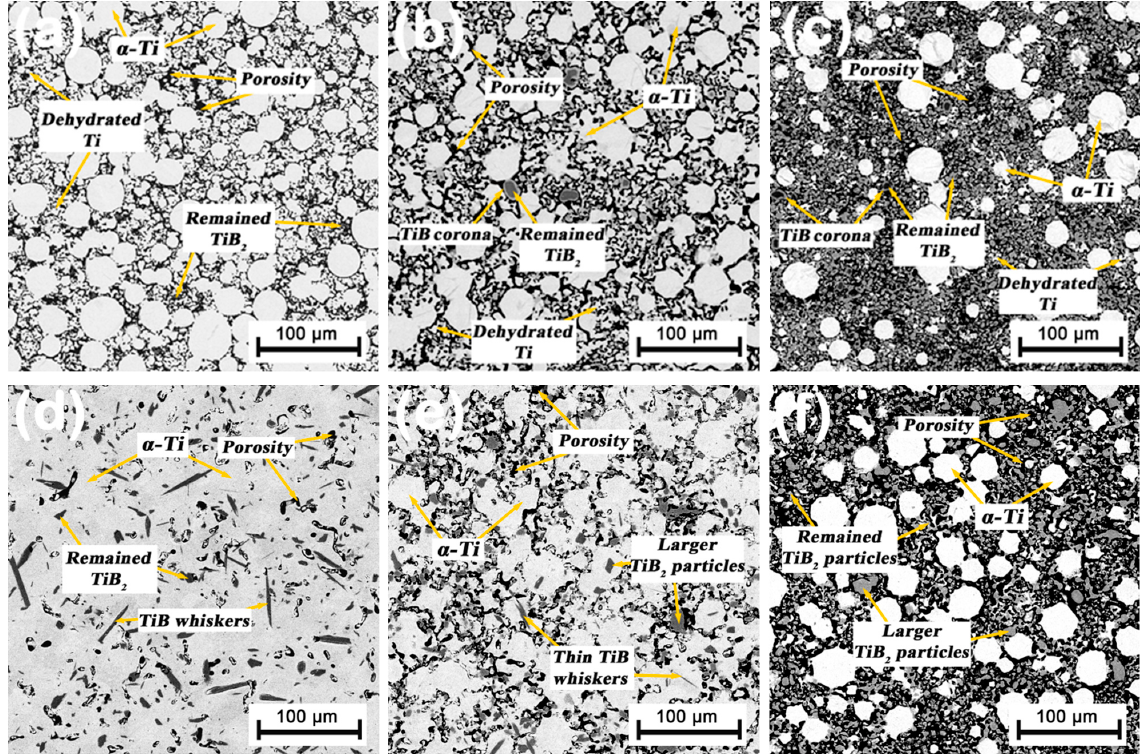
Figure 3. Microstructures of the R samples with the different reinforcement conditions after sinter- ing. ( a ) R3-a, ( b ) R10-a and, ( c ) R30-a, ( d ) R3-c, ( e ) R10-c and, ( f ) R30-c samples.